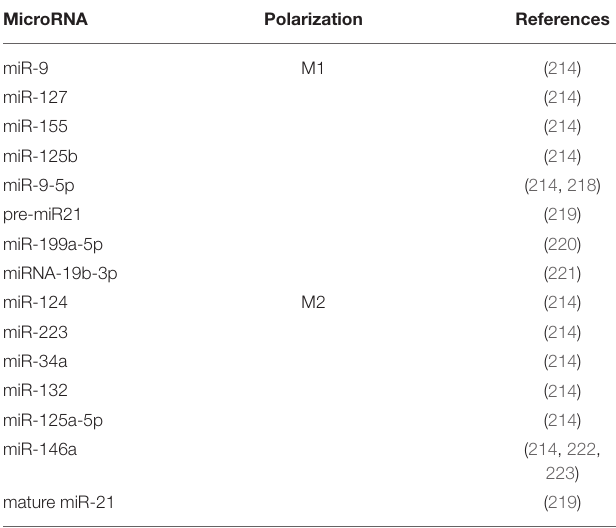
TABLE 1 | MicroRNA and macrophage polarization. MicroRNA